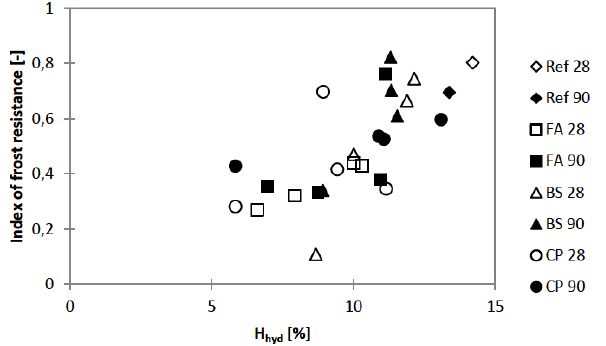
Figure 10: Relationship between Index of frost resistance (ex- pressed by help of flexural strength after 50 cycles) and amount of water chemically bound in